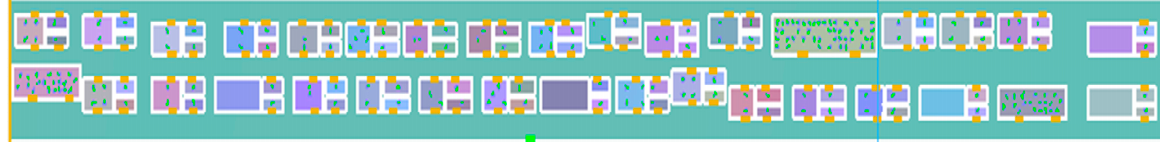
Table 6. Traffic composition of